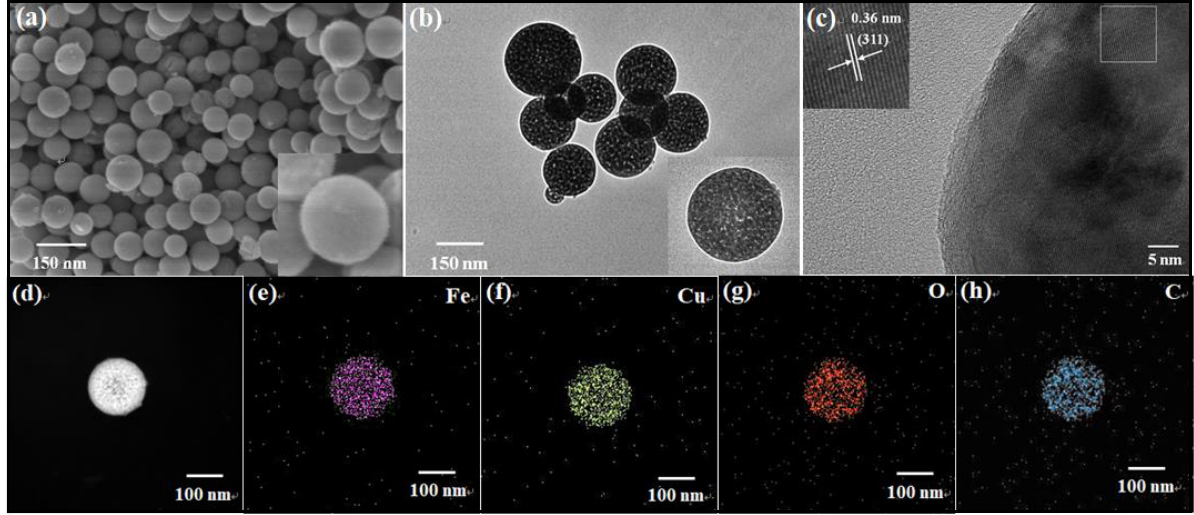
Figure 3. The SEM ( a ), TEM ( b ) and HRTEM ( c ) images for CFO/C-PNS sample; ( d ) elemental mappings of Fe ( e ), Cu ( f ), O ( g ) and C ( h ) elements of CFO/C-PNS sample.